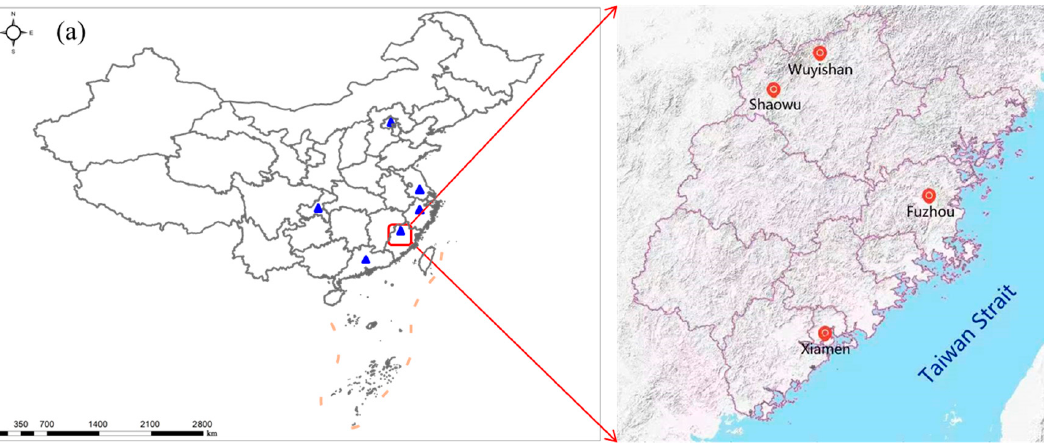
Figure 1. The geographical location of ( a ) the six national meteorological observation stations in mainland China (blue triangles) and ( b ) the Wuyishan and Shaowu stations (red dots).